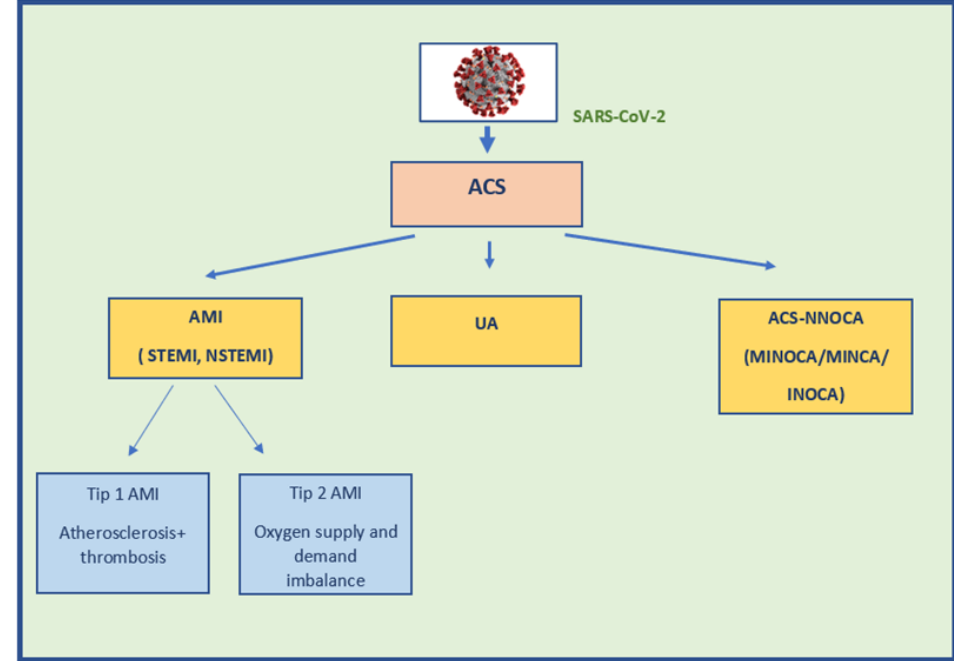
Figure 1. Different types of ACS in COVID-19. Legend: SARS-CoV-2—severe acute respiratory syndrome coronavirus 2; ACS—acute coronary syndrome; UA—unstable angina; AMI—acute myocardial infarction; ACS-NNOCA—acute coronary syndrome with normal or near-normal coronary arteries; INOCA—ischemia with non-obstructive coronary artery disease; MINCA—myocardial infarction with normal coronary arteries; MINOCA—myocardial infarction with non-obstructive coronary artery disease; NSTEMI—non-ST elevation myocardial infarction; STEMI—ST elevation myocardial infarction.